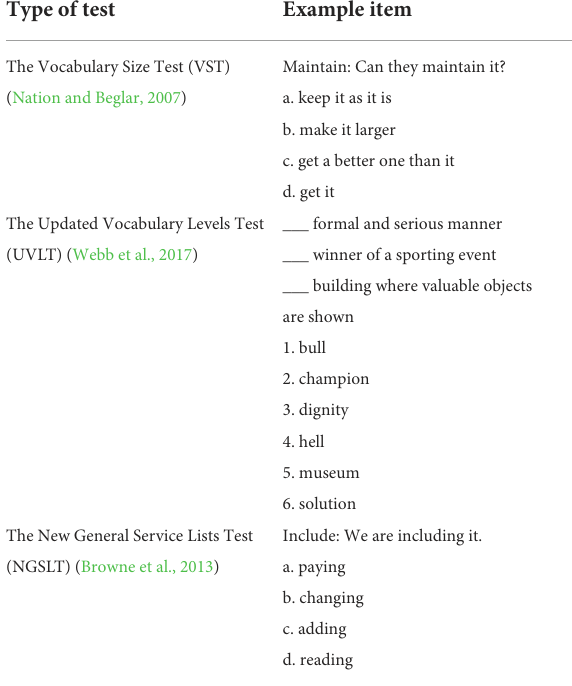
TABLE 2 Standardized tests of vocabulary knowledge. Type of